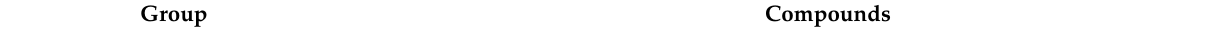
Table 1. Categories of emerging chemicals of concern in the water environment, with some examples [3,14–16]. Group Compounds Various chemicals New phthalates DPHP (Di-2-propylheptyl phthalate) Non-phthalate